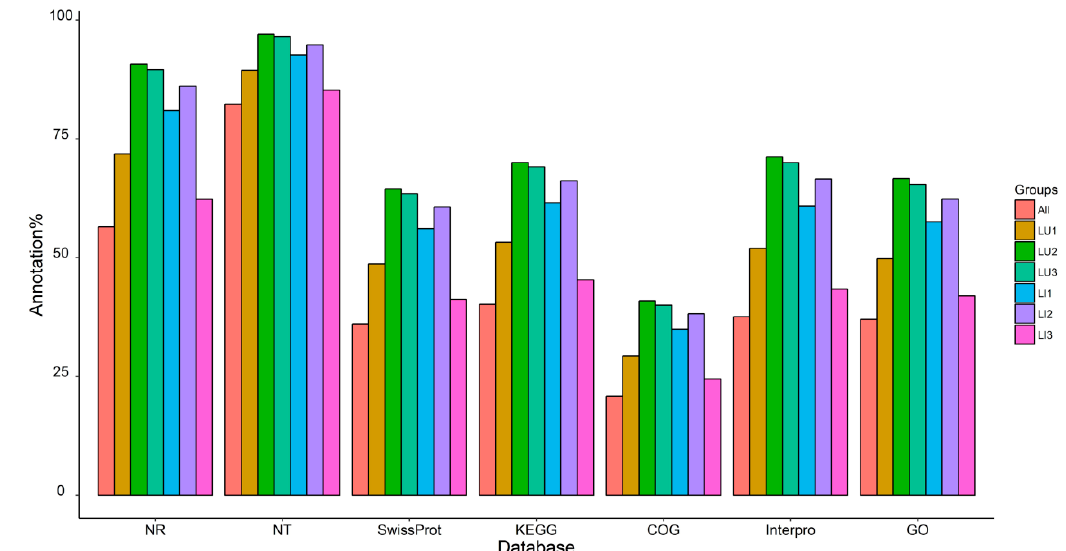
Figure 3. Functional annotation of unigenes. NR: non-redundant protein sequences; NT: non-redundant nucleotide sequences; KEGG: Kyoto encyclopedia of genes and genomes; COG: clusters of orthologous groups of proteins; GO: gene ontology.